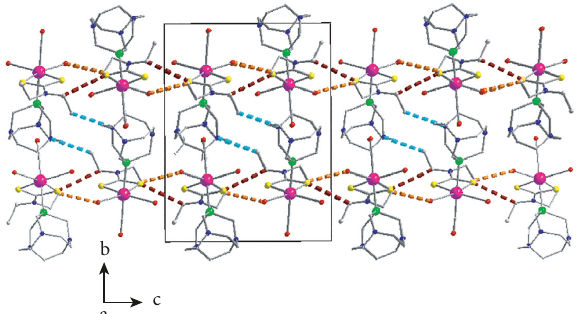
Figure 9: Stacking of layers along the b crystallographic axis in the structure of compound 3b , The dashed thick orange, dark red, and cyan O 2 , C 5 -H 5 S 2 and C 6 -H 6 B N 2 hydrogen bonds, respectively. Details for the arrangement of complexes and the lines indicate C 8 -H 8 A · ·· ·· · ·· · intermolecular interactions within the layer are presented in Figure S4.